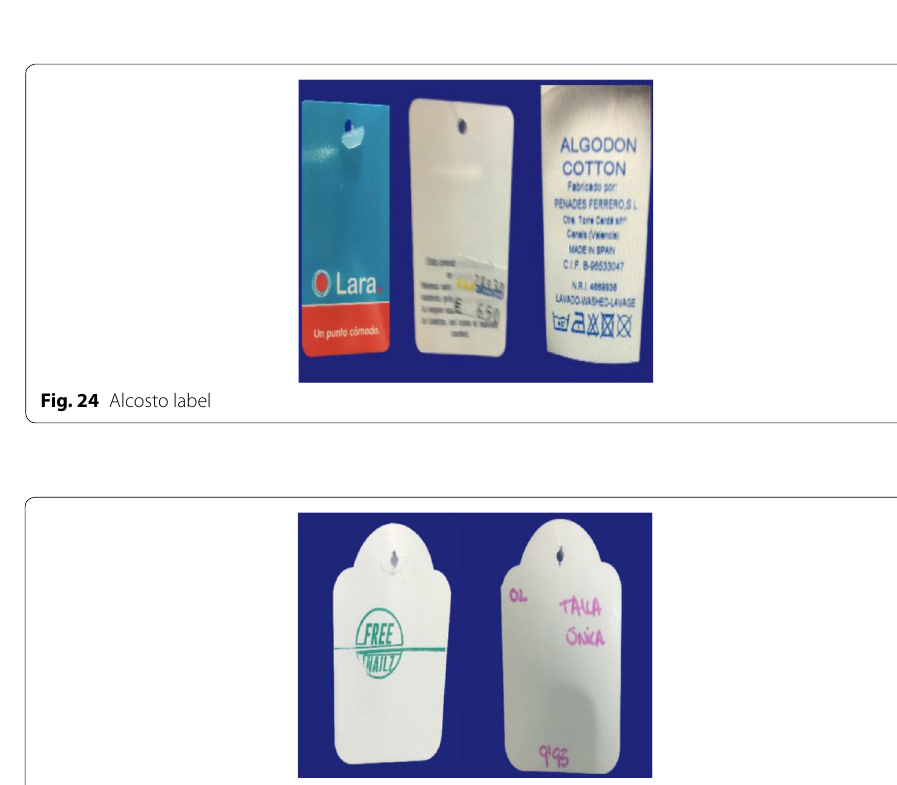
Fig. 25 FreeNailz